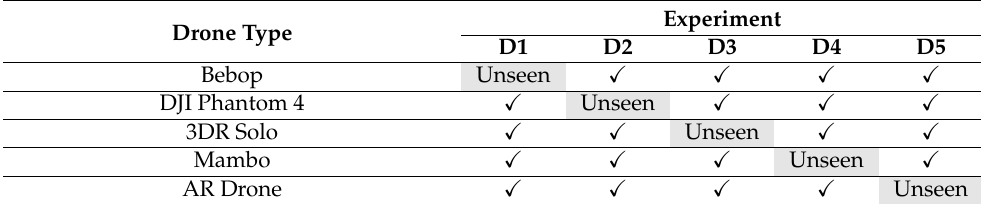
Table 3. Enhanced Drone Audio Dataset.